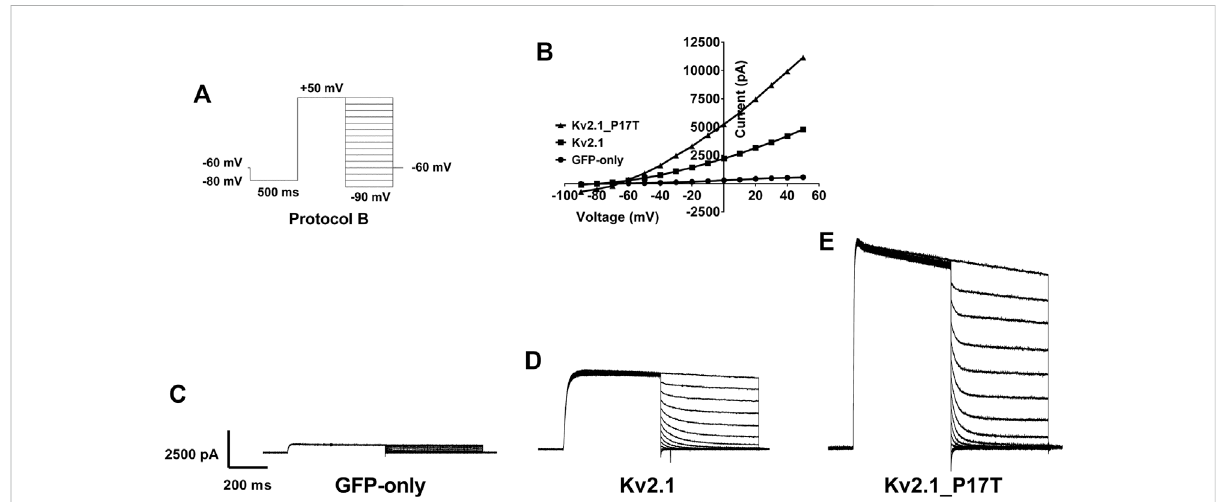
FIGURE 3 Reversal potential of currents through WT and K V 2.1-P17T channels is unaltered. (A) Schematic representation of voltage protocol B. tsA201 cells were held at − 60 mV, stepped down to − 80 mV for 500 m then to +50 mV for 500 m. 10 mV steps from +50 to − 90 mV for 500 milliseconds were then applied where the current was measured, then cells were stepped back to − 60 mV, with one sweep every 15 s, for 15 sweeps. (B) Representative peak currents measured during the hyperpolarising current steps following current activation for cells expressing GFP-only,K V 2.1-WTorK V 2.1-P17T.Notethatalthoughthecurrentsdiffergreatlyinamplitude,theyreversedirectionatthesamevoltage. (C) Average whole-cell current trace recorded using protocol B when expressing GFP-only. (D) Average whole-cell current trace recorded using protocol